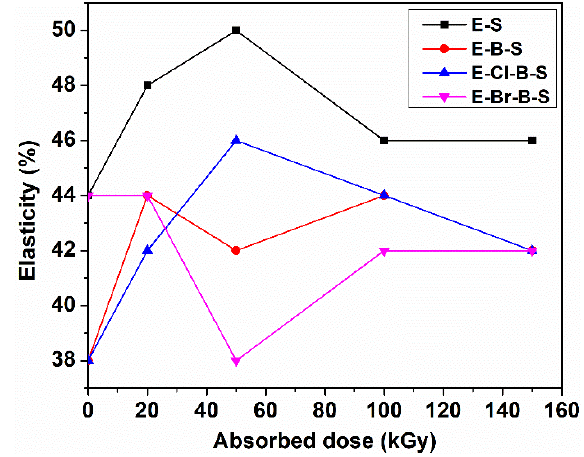
Figure 4. Elasticity as a function of irradiation dose.